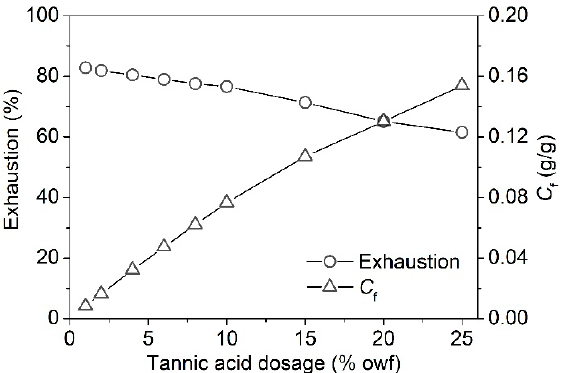
Figure 6. Building-up property of tannic acid on silk fiber.